Question: Express in one sentence what the figure is showing.
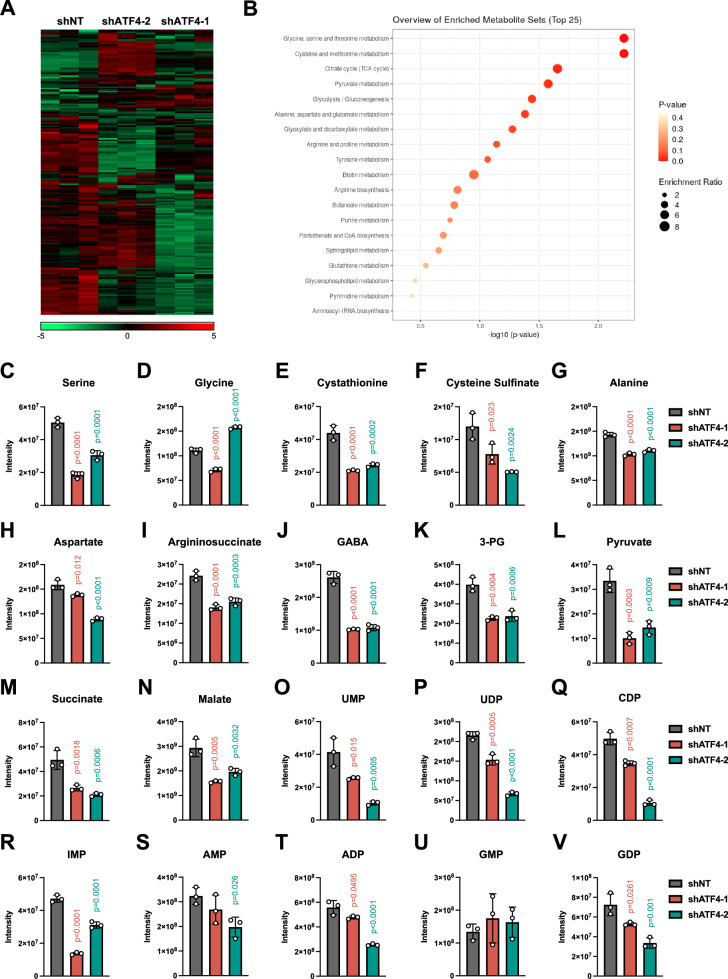
Answer: ATF4 inhibition reduces steady-state levels of amino acid and nucleotide intermediates. TPMs extracted from NOMO-1 cells expressing shNT, shATF4-1, or shATF4-2 and analyzed by HILIC-MS. A Heatmap of steady-state polar metabolite profiles from DOX-treated NOMO-1 cells expressing shNT, shATF4-1, or shATF4-2. B Pathway enrichment analysis of metabolites that were down-regulated by shATF4-2 using the MetaboAnalyst v5.0. C – V Quantification of the following steady-state TPM levels in NOMO-1 expressing shNT, shATF4-1, or shATF4-2: C serine, D glycine, E cystathionine, F cysteine sulfinate, G alanine, H aspartate, I argininosuccinate, J GABA, K 3-PG, L pyruvate, M succinate, N malate, O UMP, P UDP, Q CDP, R IMP, S AMP, T ADP, U GMP, and V GDP. For C – V , all graphed data represent the mean ± SD of three technical replicates from one biological replicate. Two independent, biological replicates were carried out. Statistics are derived from a one-way ANOVA comparing the shNT control and the shATF4-1 (pink p -values) and shATF4-2 (teal p -values) conditions. A Dunnett’s multiple comparisons test (95% CI) was also performed. Exact adjusted p -values are listed in the Source Data File. Source data for ( A ), as well as C – V are provided in the Source Data file.